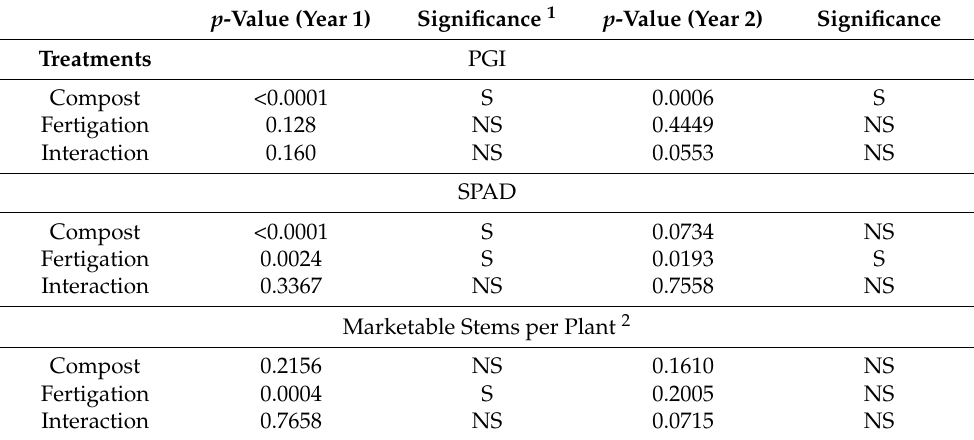
Table 2. Significance of pre-plant compost and fertigation during the growing season on plant growth index (PGI), leaf SPAD readings, and marketable stems per plant of zinnia “Benary’s Giant Mix” grown in a high tunnel.